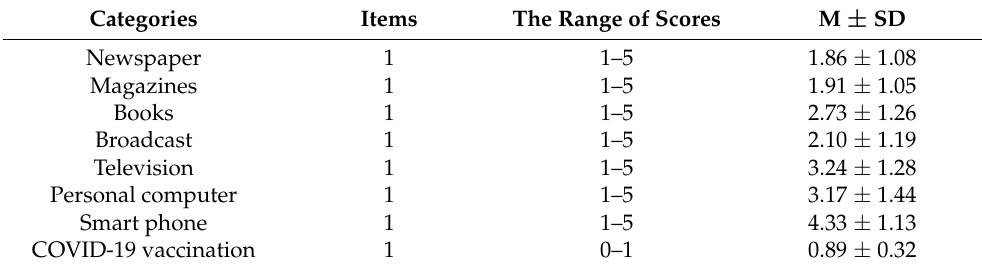
Table 3. Media use and COVID-19 vaccination scores of subjects.